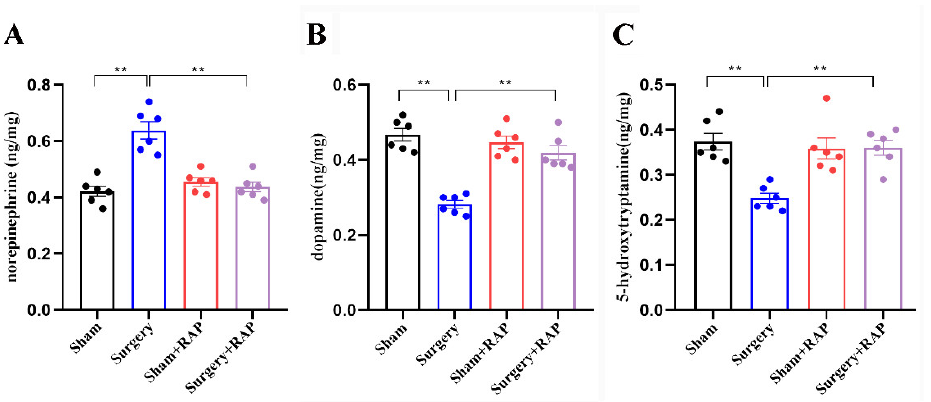
Figure 6. Rapamycin reversed surgical stress-induced imbalances of neurotransmitters in hippocampal synaptosomes. Levels of norepinephrine ( A ) were upregulated in synaptosomes of rats that underwent surgery compared with those in synaptosomes of sham rats. Dopamine ( B ) and 5-hydroxytryptamine ( C ) were downregulated in synaptosomes of rats that underwent surgery. n = 6 rats per group. ** p < 0.01 surgery vs. sham group or surgery+rapamycin vs. surgery group. RAP: rapamycin.